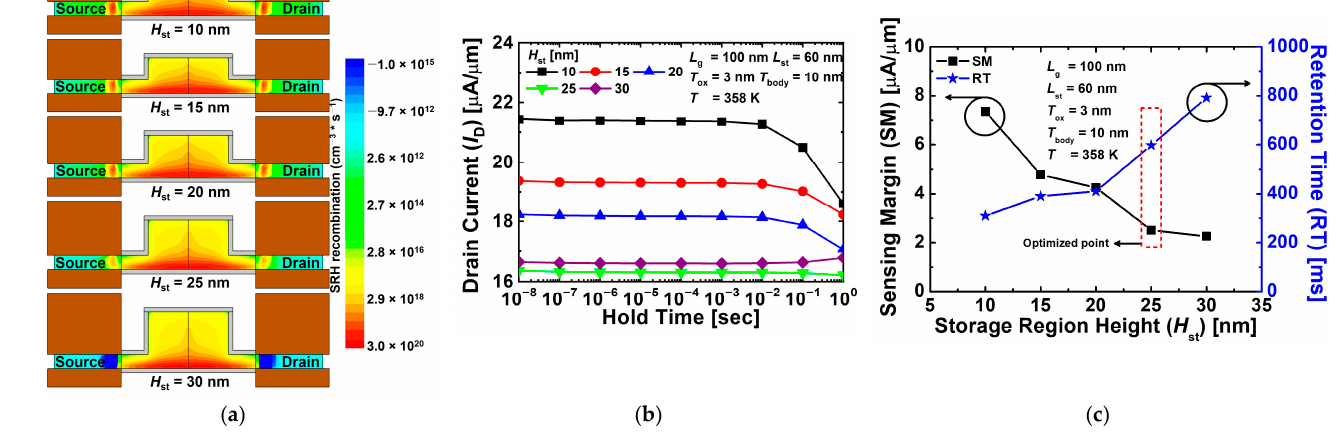
Figure 9. ( a ) Contour map of SRH recombination rate for proposed 1T-DRAM with different H st in hold state “1” operation. ( b ) Read “1” current of proposed 1T-DRAM with different H st . ( c ) Sensing margin and retention time of proposed 1T-DRAM cell as a function of H st .